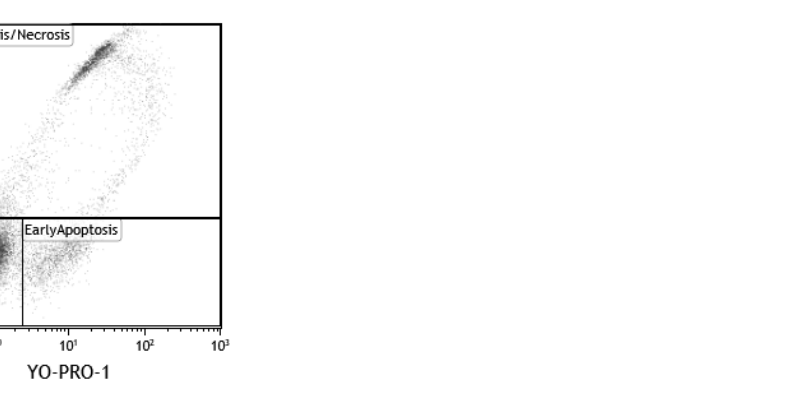
Figure 12. The gating tactics in the viability analysis of the TNR-1 cell line.